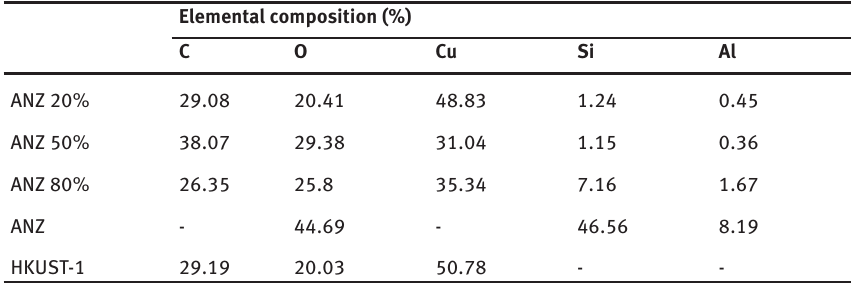
Figure 3 : SEM images of (a) HKUST-1; (b) ANZ; ANZ@HKUST-1: (c) ANZ 20%, (d) ANZ 50%, and (e) ANZ 80% (provided in 20,000 magnification). Table 1 : Percentage of elements on the composite